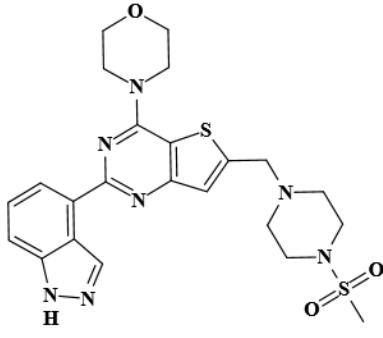
Figure 1. Chemical structure of GDC-0941.